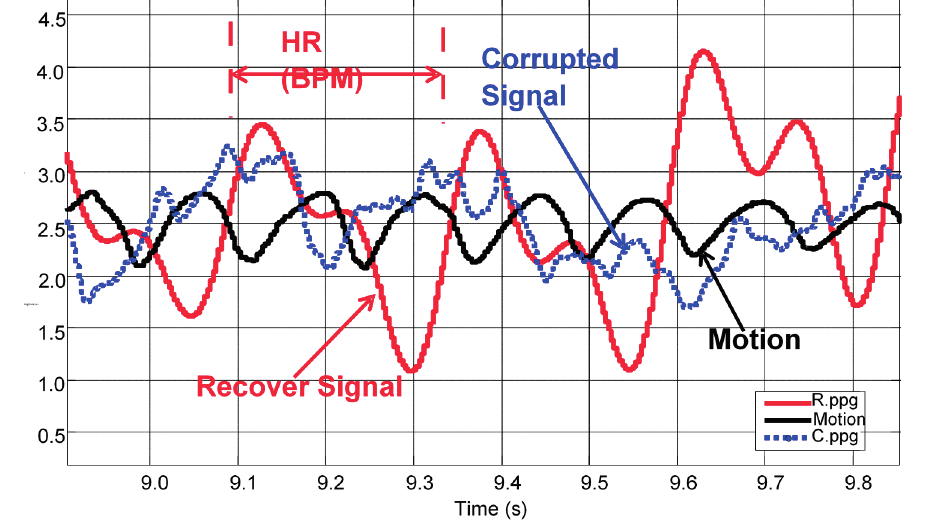
Figure 15. Recovery of PPG signals using motion artefact reduction (MAR).